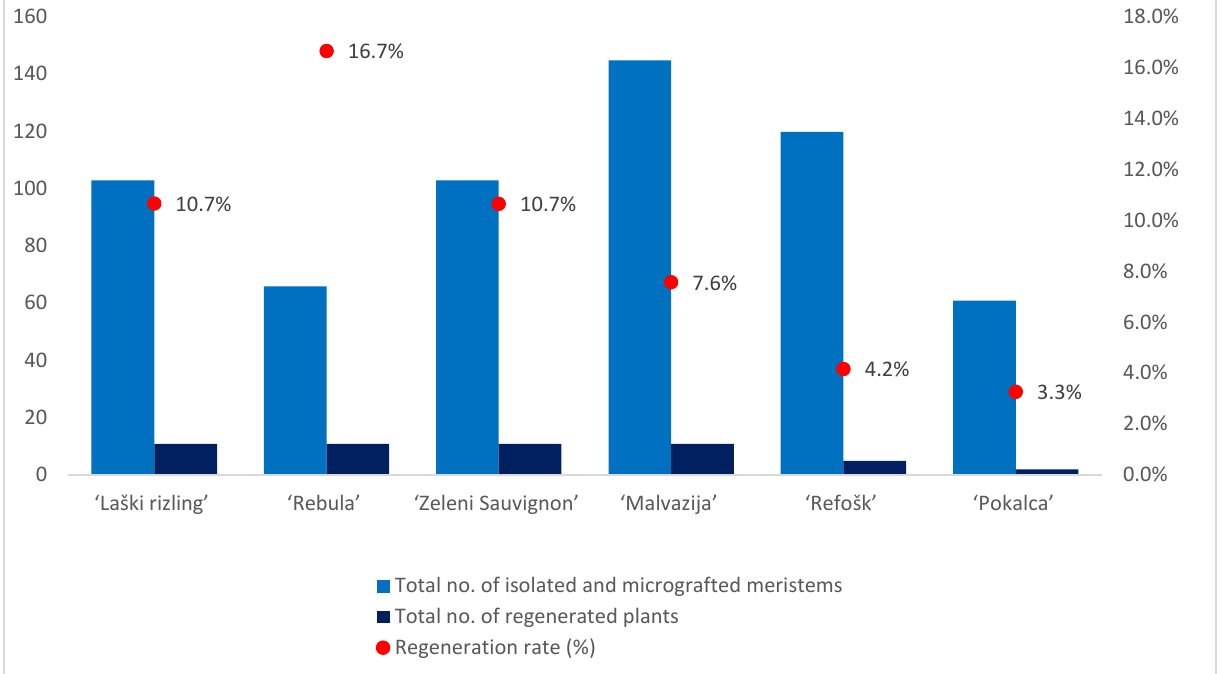
Figure 2. Number of isolated and micrografted meristems, number of regenerated plants, and regeneration rate per